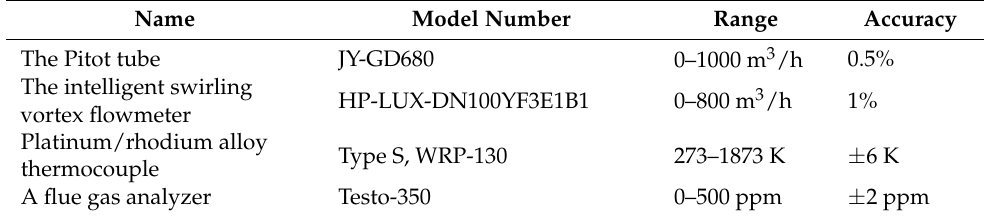
Table 2. Experimental equipment